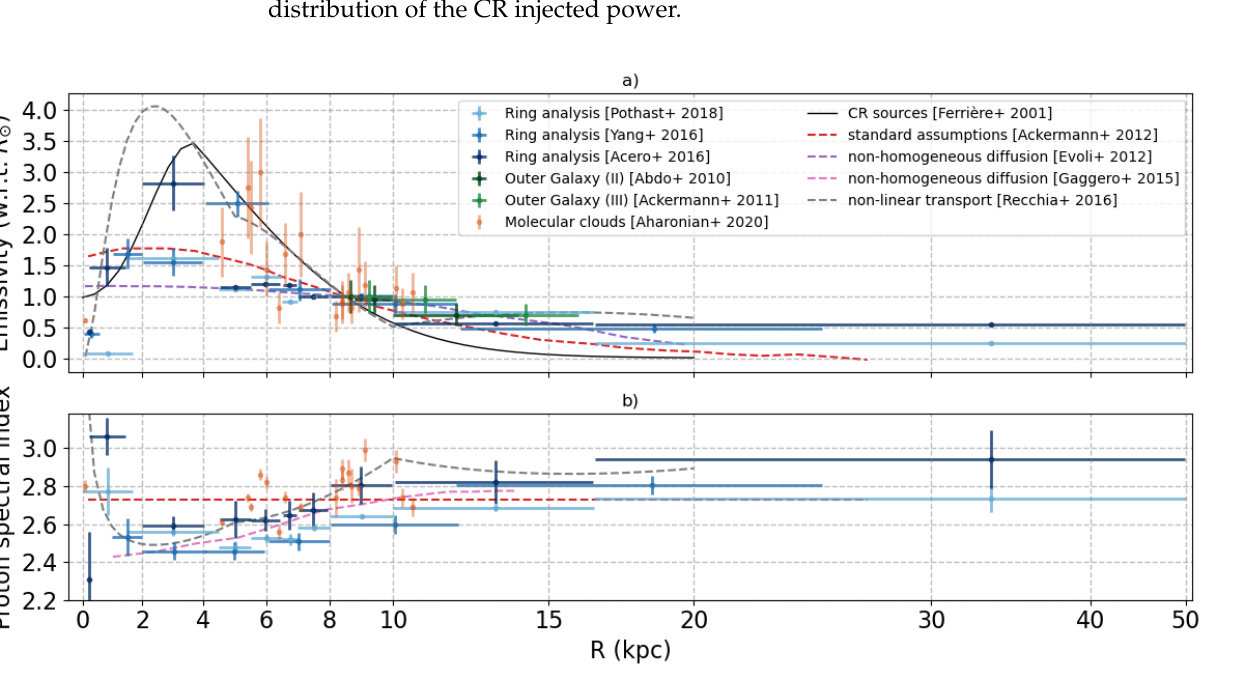
Figure 3. ( a ) Gamma-ray emissivity/CR proton density as a function of Galactocentric radius derived for the entire Milky Way using ring analyses [229–231], for the outer Galaxy [205,206], and for a sample of giant molecular clouds [233]. Values are normalised for each set of measurements by the value for the region including the solar circle ( R (cid:12) = 8.5 kpc). For giant molecular clouds the normalization is the average for all clouds in the Gould Belt ( R between 8.2 kpc and 9.1 kpc). ( b ) CR proton spectral index as a function of Galactocentric radius derived by a subsample of the analyses shown in the top panel. We remark that the gamma-ray energy range considered varies between the different analyses, but whenever readily available we show in the plot the inferred CR proton density and spectral index at 10 GeV. In both panels we include predictions from some of the models discussed in the text, namely a standard CR model implementation [238] (red), two models with non-homogeneous diffusion tuned to reproduce the CR density profile in the outer Galaxy [175] (purple) and the inner-Galaxy hardening [250] (pink), and the non-linear transport model by Recchia et al. [251] with exponential cutoff of the magnetic field strength at large R (grey). In the top panel we also show the putative CR source profile taken from [252] (black) as useful